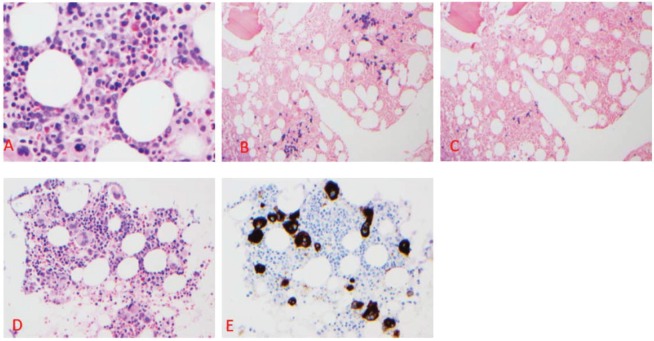
Clustering of lambda-light chain restricted plasma cells on Bone marrow biopsy section (A–C). A. HE × 200; B. Lambda light chain ISH x100; C. Lambda light chain ISH x100. D. Focal loose clustering of megakaryocytes. A HE ×200; E CD61 immunohistochemical stain ×200.